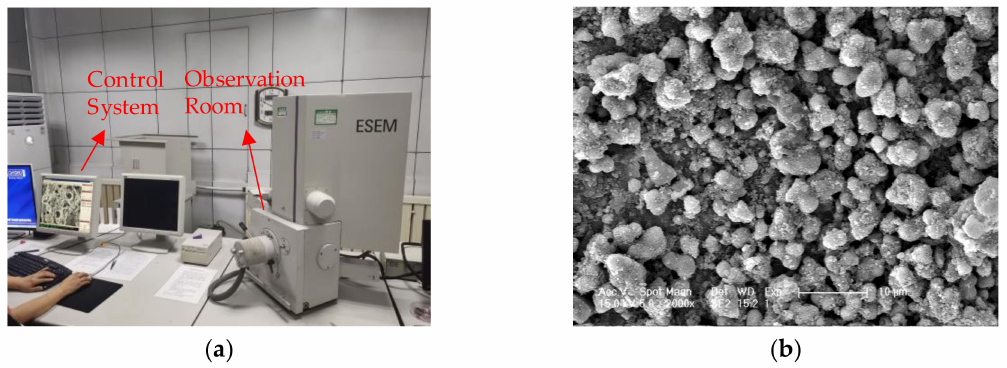
Figure 5. The sampling diagram and processed samples: ( a ) schematic diagram; ( b ) processed samples.